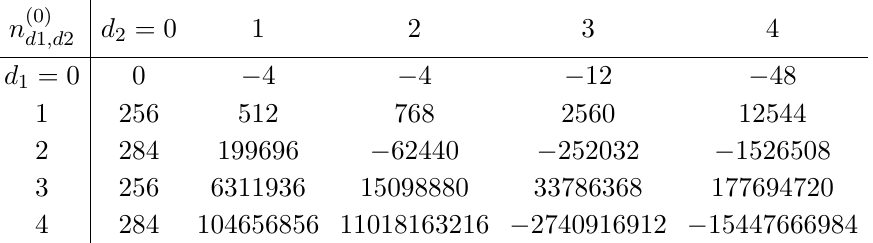
1 with q = exp(2 πit 1 ) in the 1 → 1